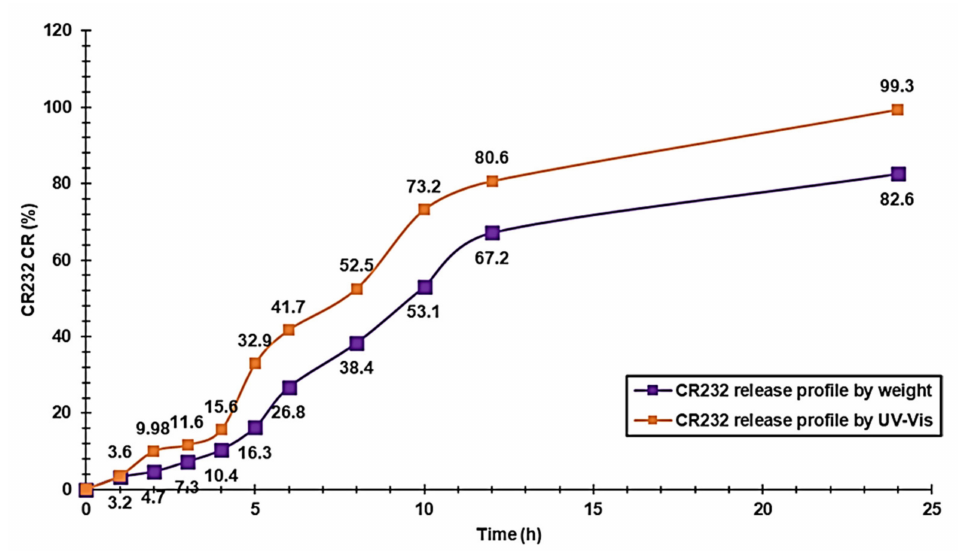
Figure 4. CR232 CR% at pH 7.4 during 24 h obtained both by weighing the CR232 amounts in PBS solutions at fixed time points (purple line) and by UV-Vis analyses of these samples re-dissolved in DMSO (orange line). The error bars have not been reported on the graph to avoid